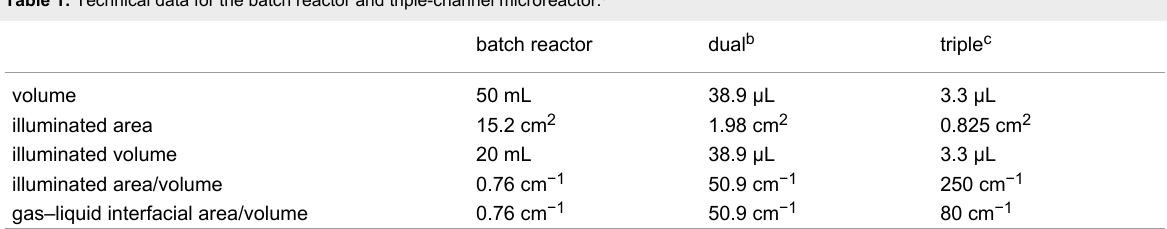
Table 1: Technical data for the batch reactor and triple-channel microreactor. a